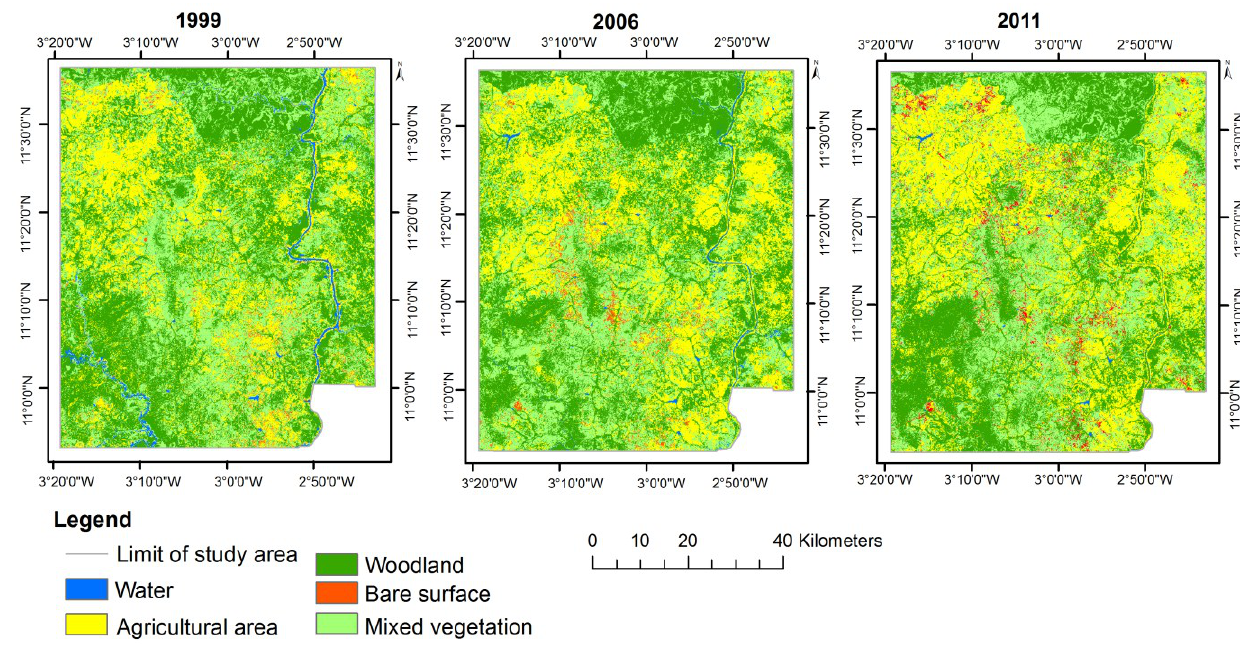
Figure 4. LULC spatial distribution in the study area in 1999, 2006 and 2011.